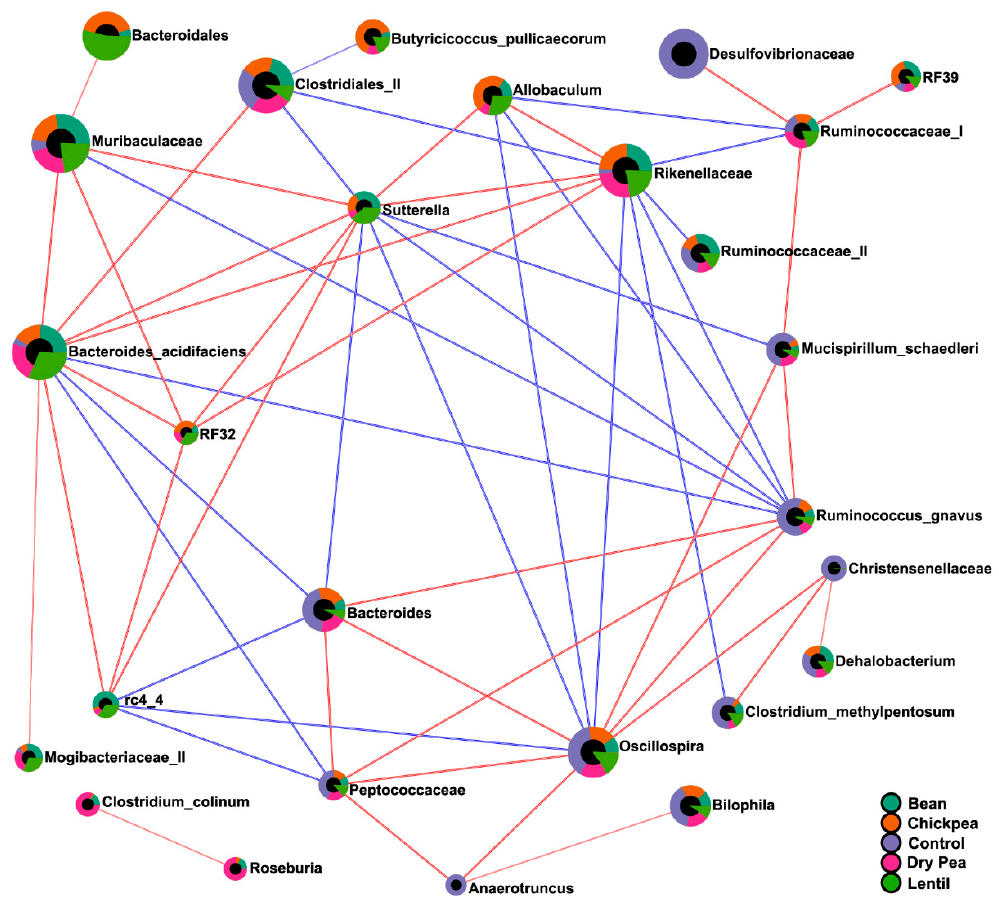
Figure 7. Correlation network of cecal microbiota across the diet groups. Each node represents a taxon, colored by the mean abundance in a respective diet group. Nodes are connected by the edges representing correlations and their value between taxa pairs: blue indicates negative, while red indicated positive correlation. A correlation network was generated using the SparCC algorithm with 100 permutations, depicting only taxa that met the p -value threshold 0.05 and the correlation threshold 0.7.